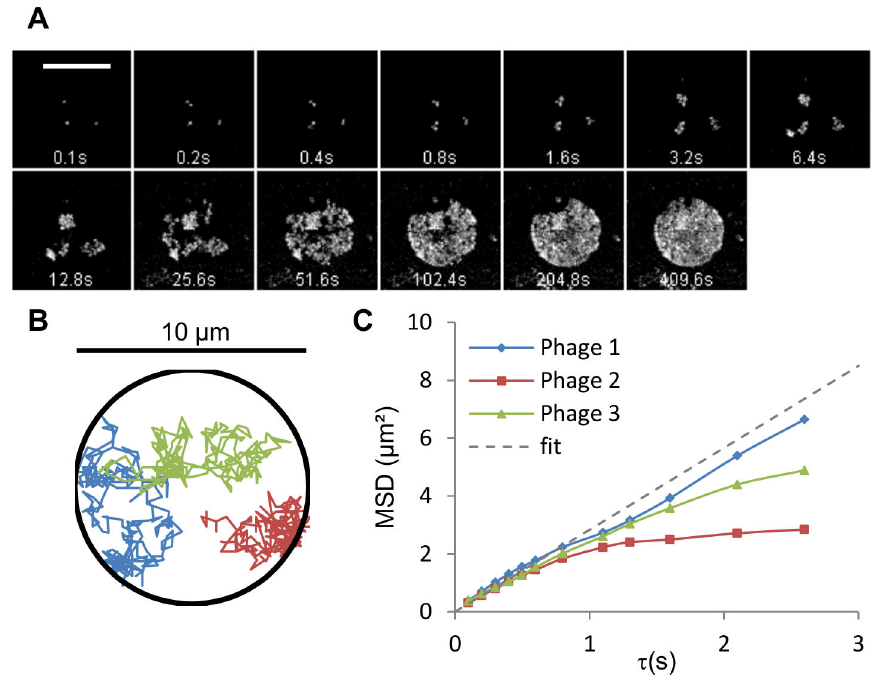
Figure 5. Phage T5 diffusion on lipid membrane. A\ Fluorescence image series showing diffusion of three individual T5 phages. The images are centered on the capillary ID. Three bound phages are visible on the suspended bilayer part (circular patch, 10 μm in diameter), for which intracapsid DNA is stained (Yo-Pro I). To emphasize the regions explored by the phages, a series of maximum intensity projection over time is performed; successive images correspond to a doubling time period, starting from one image (0.1 s). B\ Tracked trajectories of the 3 phages over a 10 s period. C\ Diffusion coefficient calculation for the three phages. MSD stands for mean squared displacement. The mean of the three values obtained for each phage is 2.6 μm 2 .s -1 . Deviation from free Brownian motion (dashed line) is a consequence of constrained diffusion area (see phage